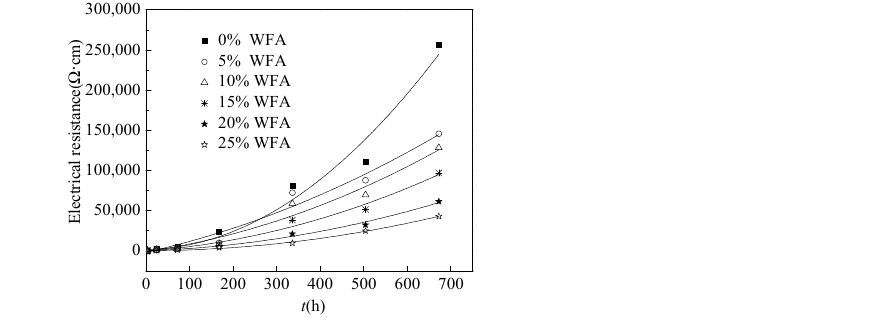
Table 3. Mixing mass proportion of cement paste.